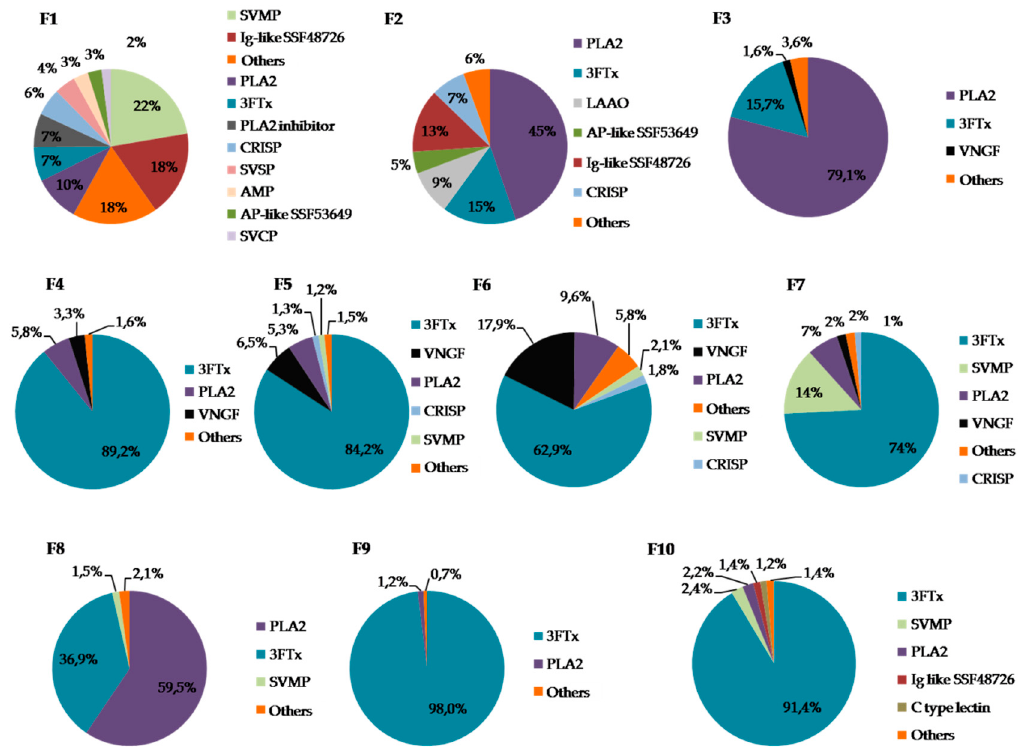
Figure 4. The percentage distribution of particular protein groups in each fraction estimated using semi-quantitative MS analysis. (SVMP—Snake venom metalloproteinase, Ig-like SSF48726— Immunoglobulin-like domain-containing protein; PLA2—Phospholipase A 2 , 3FTx—Three-finger toxin, CRISP—Cysteine-rich secretory protein, SVSP—Snake venom serine proteases, AMP—Antimicrobial peptide, AP-like SSF53649—Alkaline phosphatase-like protein, SVCP—Snake venom cysteine protease,